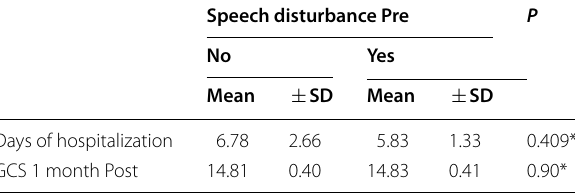
Table 9 Cases with and without preoperative motor weakness compared regarding final study outcomes